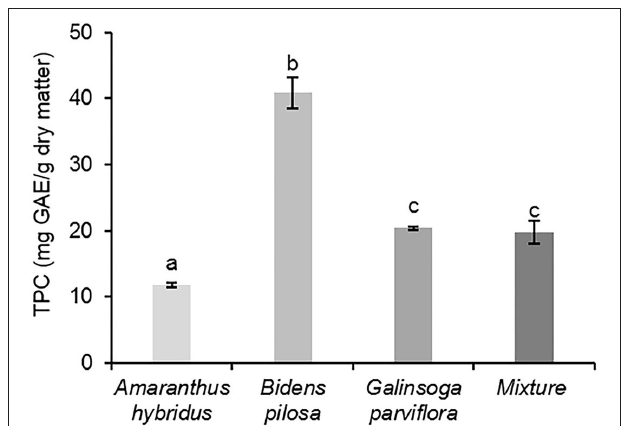
FIGURE 3 | Protein contents of lombi . Bars represent means ± standard deviations ( n = 9). Different letters indicate significant differences between samples.